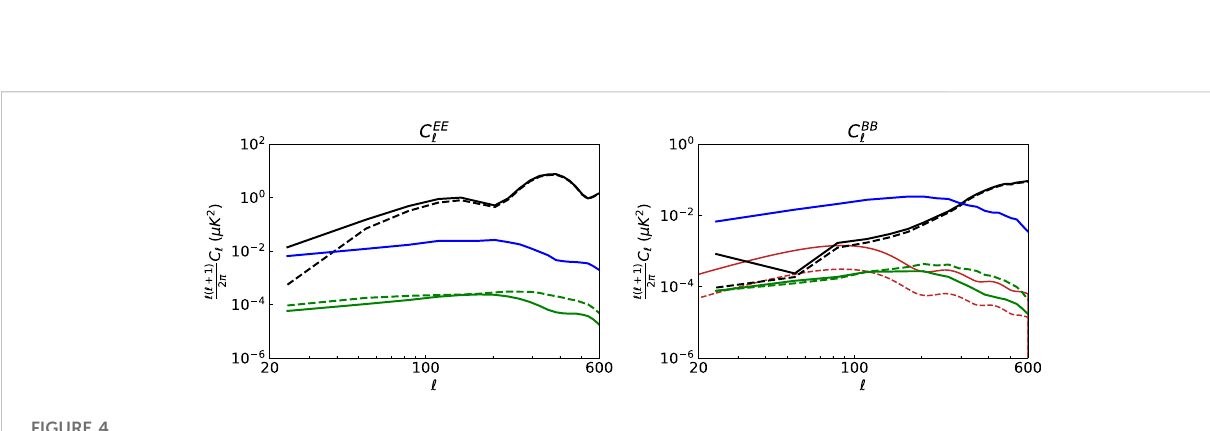
FIGURE 4 Same as in Figure 2, but for the case of multiple point sources with unknown polarization directions. The red reference spectrum are still for the unlensed CMB BB with r = 0.023 and r = 0.005, respectively.